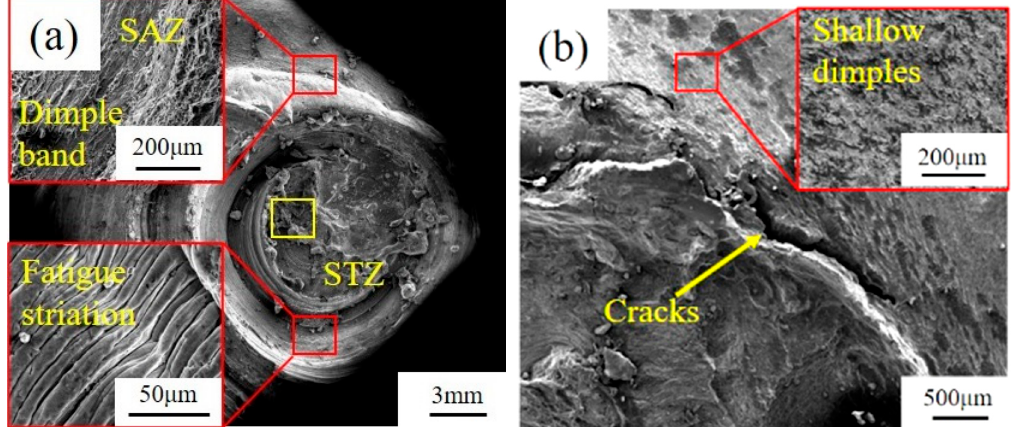
Figure 10. Micro fatigue fracture morphology of dissimilar Al/steel keyhole-free FSSW joints under asymmetric fatigue load ( a ) and under low-stress symmetric fatigue load ( b ).